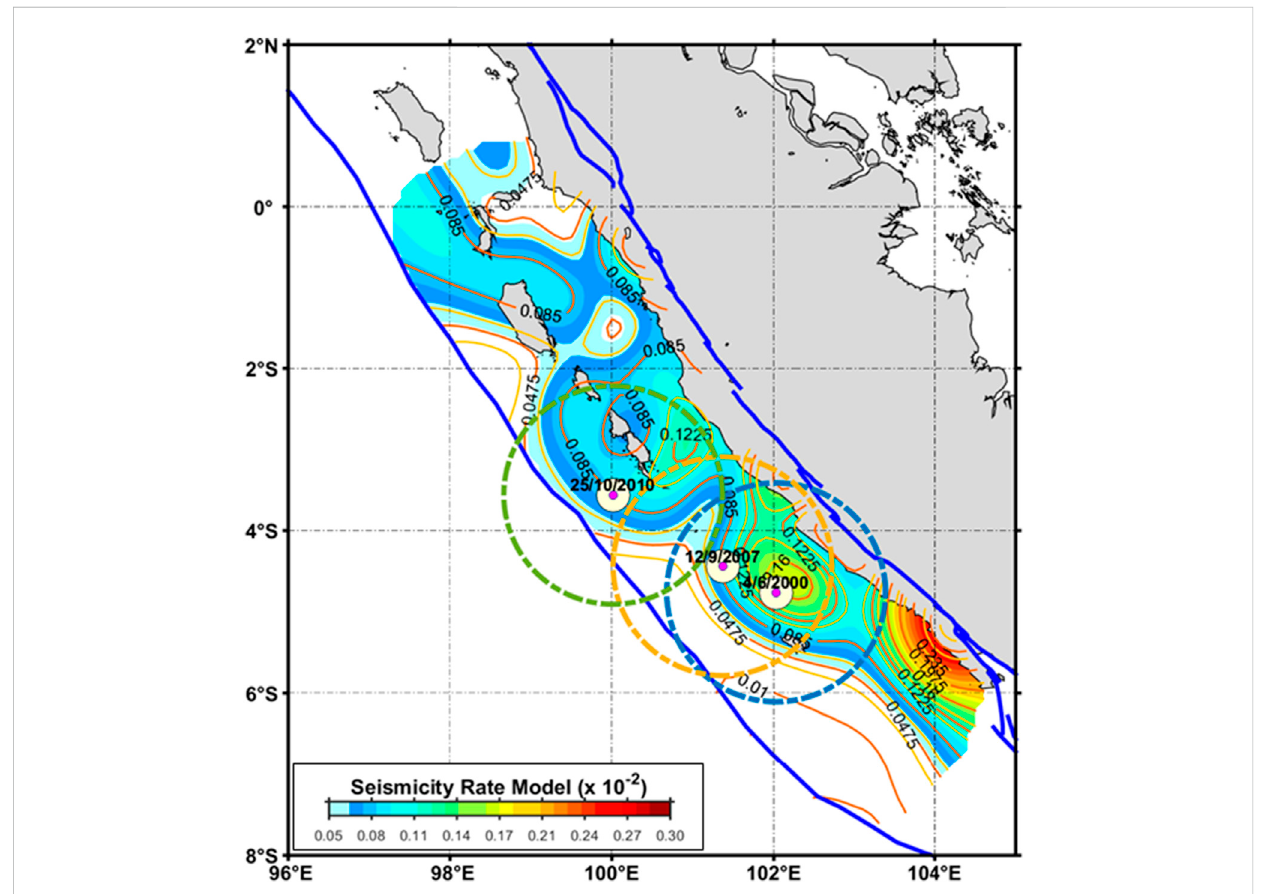
FIGURE 4 Seismicity rate model overlaid with earthquakesof M7.9in 2000, M8.5 in2007,M7.8 in 2010,and thethree-pointobservation placed intheposition epicenter.Theseismicityratemodelisconstructedbasedontheuniform